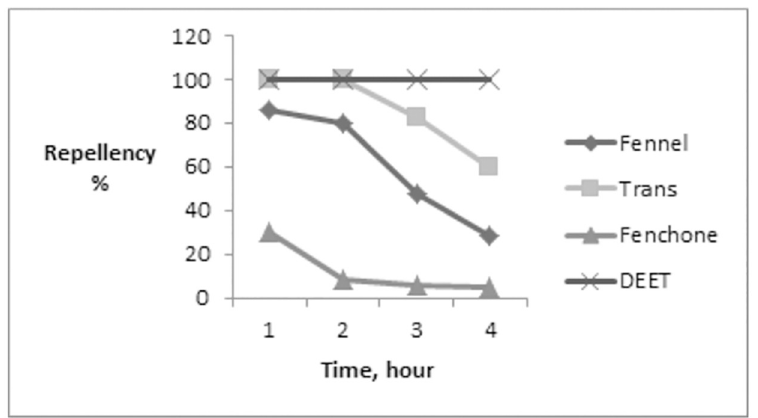
Fig 5. Repellency efficacy (%) of fennel essential oil, trans-anethole and fenchone against the R . annulatus larvae at concentration of 10% with application of DEET 7.5% as control positive.